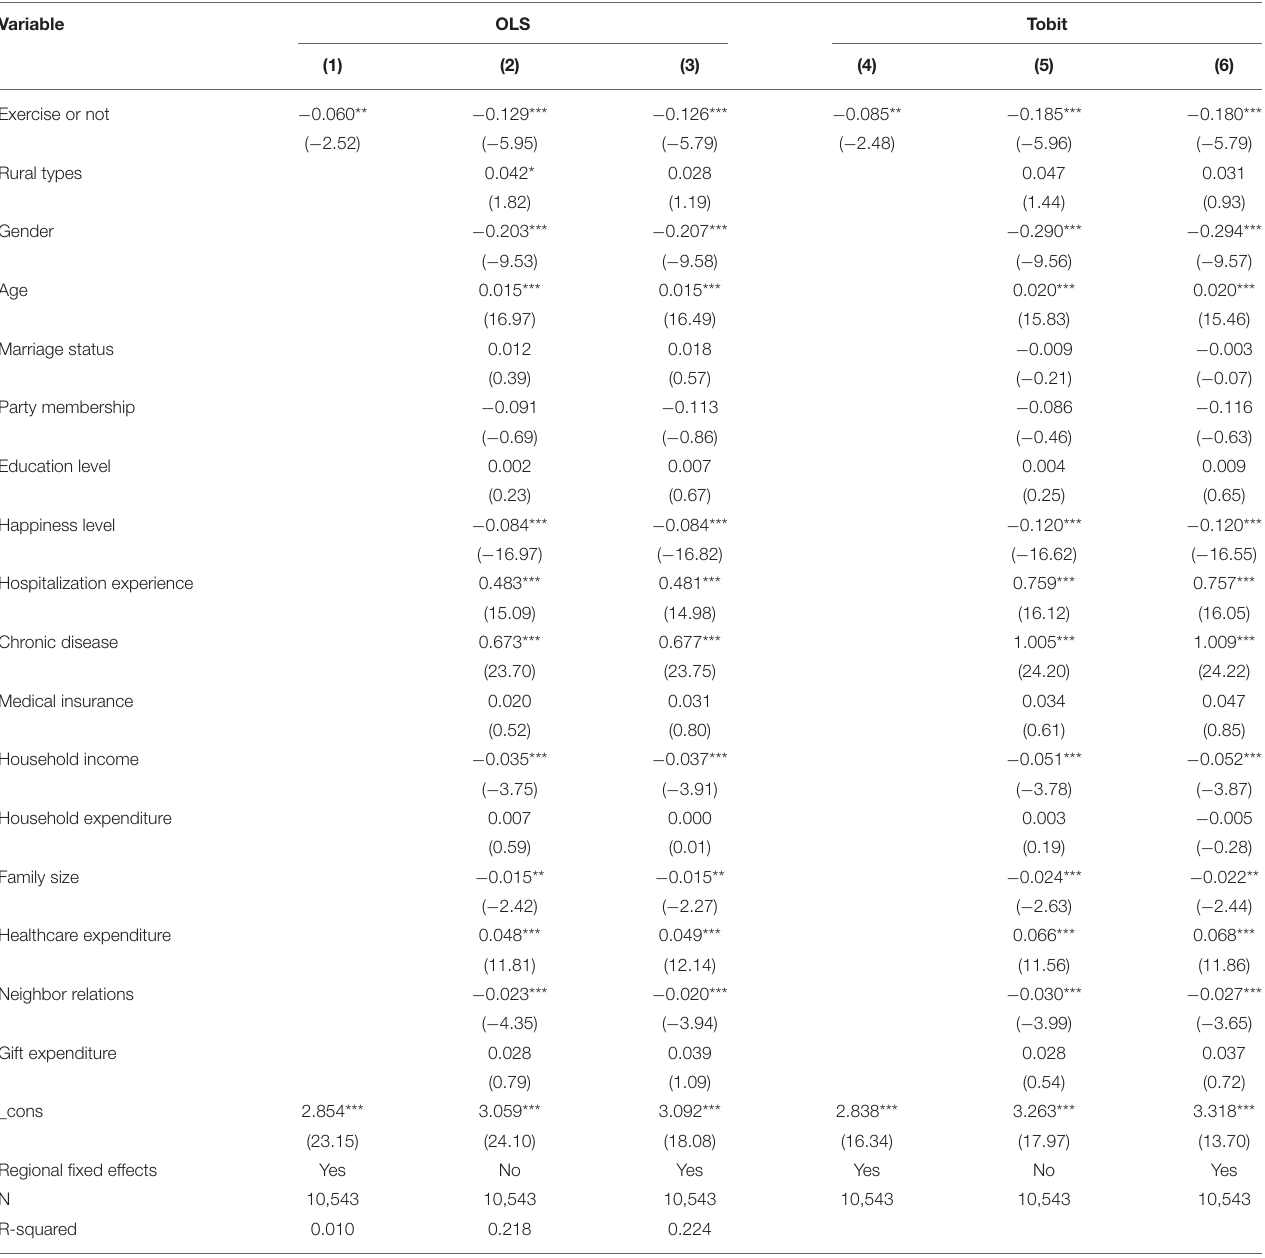
TABLE 4 | Robustness test (replace explanatory